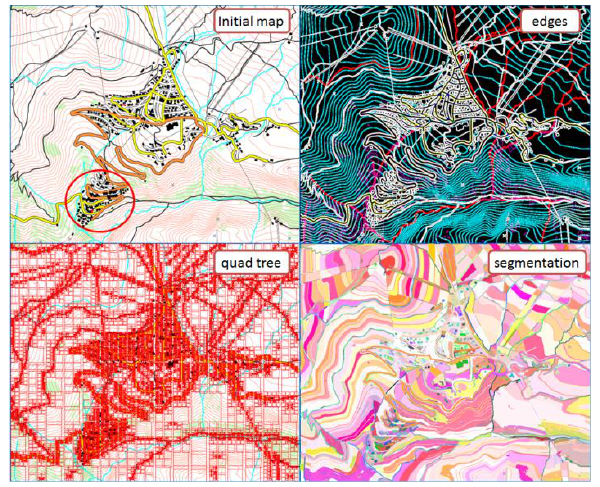
Figure 6. Identification of a cluttered area (circled in red in the initial